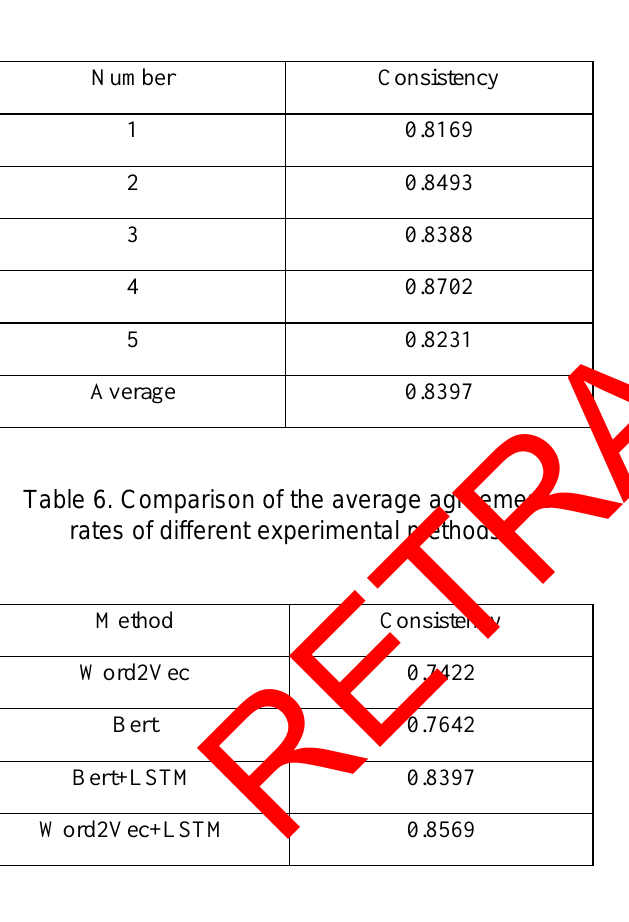
Table 5. The consistency rate between Bert+LSTM model score and teacher score